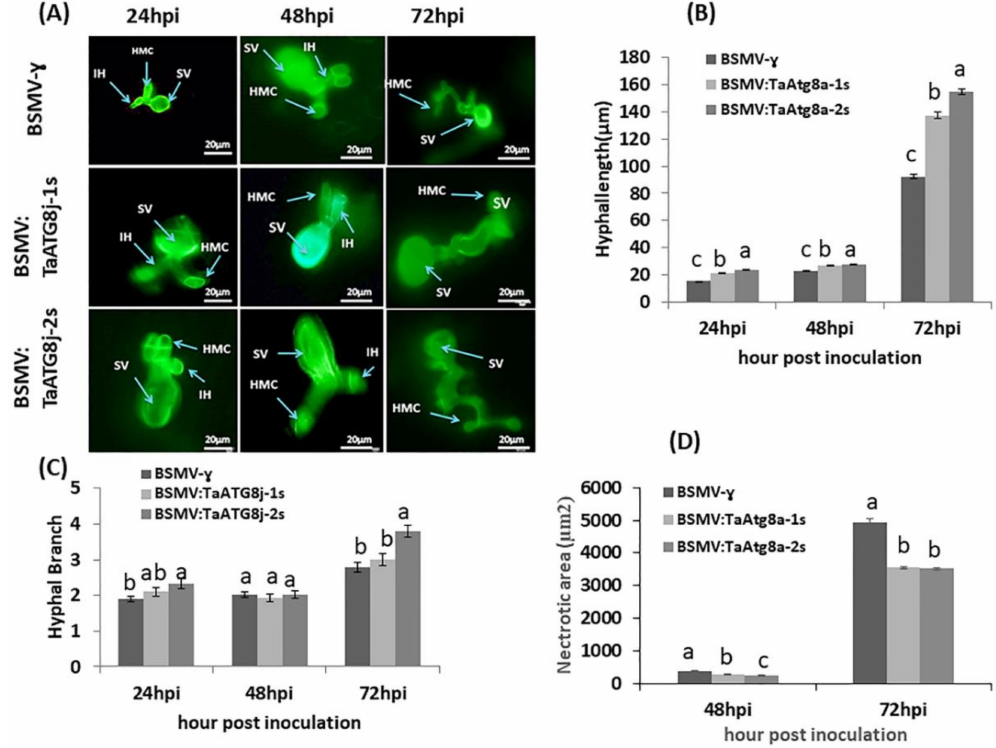
Figure 9. Histological observation of TaATG8j- silenced plants challenged with the avirulent Pst pathotype CYR23. After removing chlorophylls, the samples were stained with wheat germ agglutinin (WGA). Sample leaves were considered recombinant BSMV: γ , BSMV:TaATG8j-1s and BSMV:TaATG8j-2s that had been previously inoculated with pathotype CYR23. ( A ) Leaves were observed at 24, 48 and 72 hpi. The infected sites were observed using an epifluorescence microscope. HMC: haustorial mother cell; SV: substomatal vesicle; IH: infection hyphae. Each result was considered from 50 infection sites. Bar, 20 µ m; ( B ) Hyphal length: the distance from the joint of the substomatal vesicle to the apex of the hypha; ( C ) Hyphal branches: the average numbers of primary hyphae; ( D ) Necrotic area: quantified as the area of autofluorescence. Different letters indicate significant differences ( p < 0.05) using the Tukey HSD